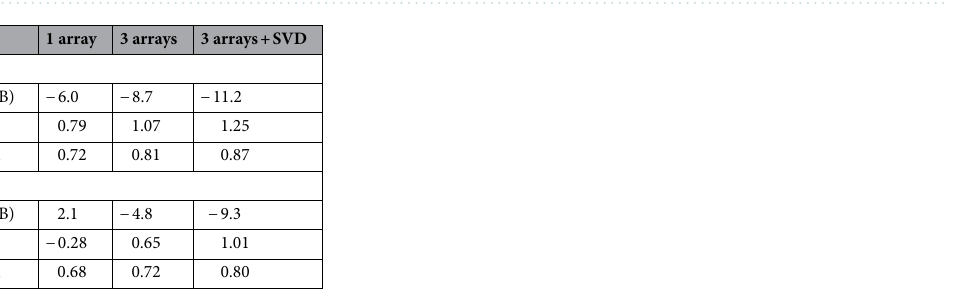
Figure 7. Imaging of liver on a volunteer using the central array ( a , g ), all three arrays ( b , h ) and after applying the SVD beamformer ( c , i ). The close up view indicated in ( a ) and ( g ) by a yellow square is displayed for all three cases in ( d ) and ( j ) (one array), ( e ) and ( k ) (three arrays) and ( f ) and ( l ) (three arrays + SVD). The dynamic range for all the images is 60 dB. The circular regions of interest (ROI) indicates where the contrast metrics were evaluated.